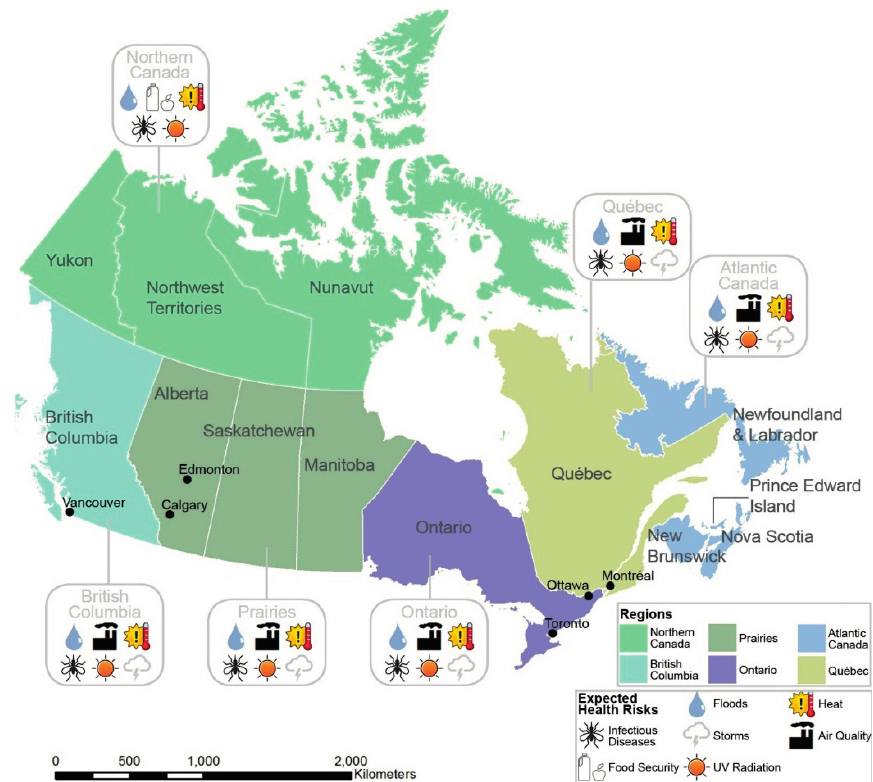
Figure 1. Expected health risks posed by climate change by